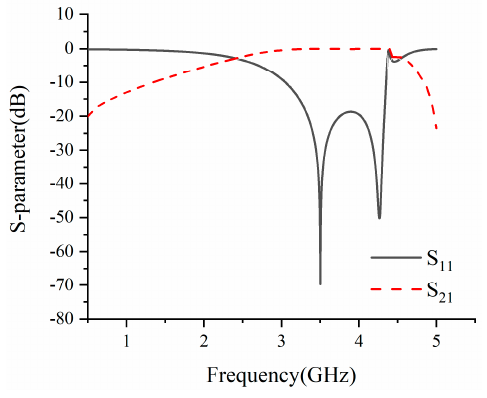
Figure 4. The simulated scattering parameters (S-parameters) of filter at 2.4 GHz.